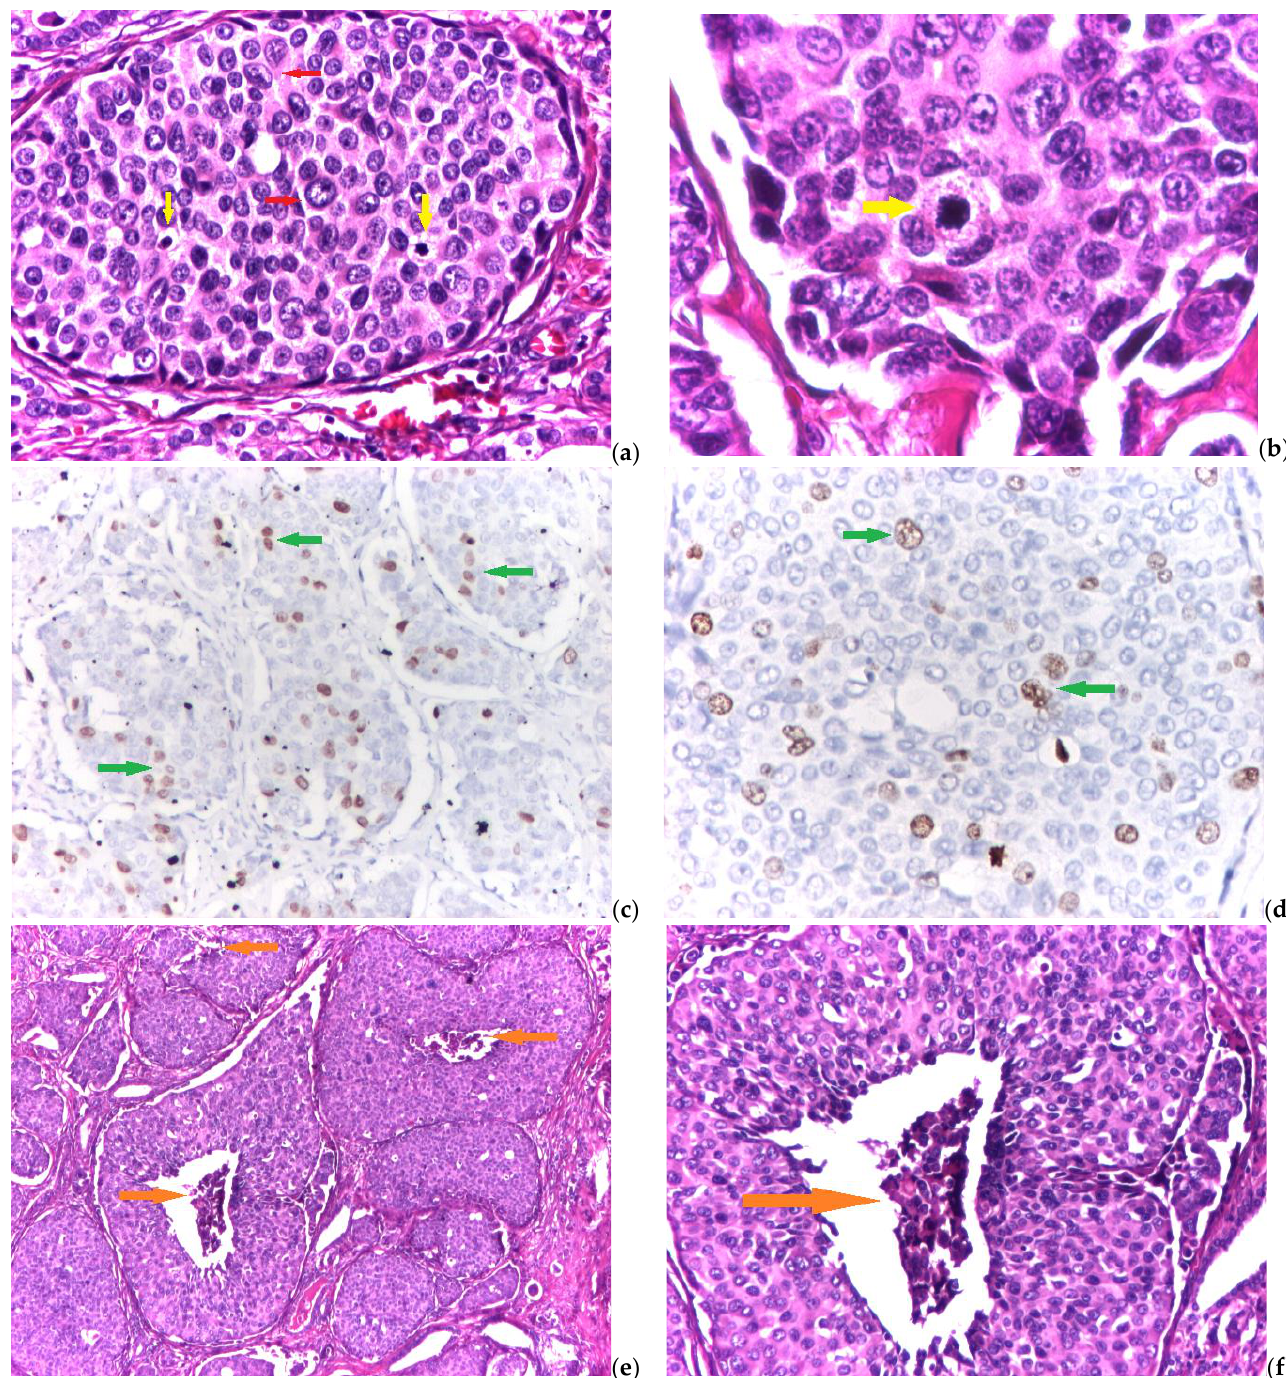
Figure 2. ( a – f ) Grading system parameters for high-grade medullary thyroid carcinoma: ( a ) solid area with nuclear pleomorphism — red arrows and two mitosis — yellow arrows (hematoxylin and eosin — H and E, magnification 10×), ( b ) detail for atypical mitosis — yellow arrow (hematoxylin and eosin — H and E, magnification 40×), ( c ) numerous Ki67 positive cells — green arrows — in solid tumor areas (immunohistochemical reaction — IHC, antiKi67 antibody, magnification 10×), ( d ) detail for Ki67 proliferative index — green arrows (immunohistochemical reaction — IHC, antiKi67 antibody, magnification 20×), ( e ) multiple foci of prominent tumor necrosis — orange arrows (hematoxylin and eosin — H and E, magnification 4×), and ( f ) detail for necrotic cells and karyorrhectic nuclear detritus — orange arrow (hematoxylin and eosin — H and E, magnification 10×).